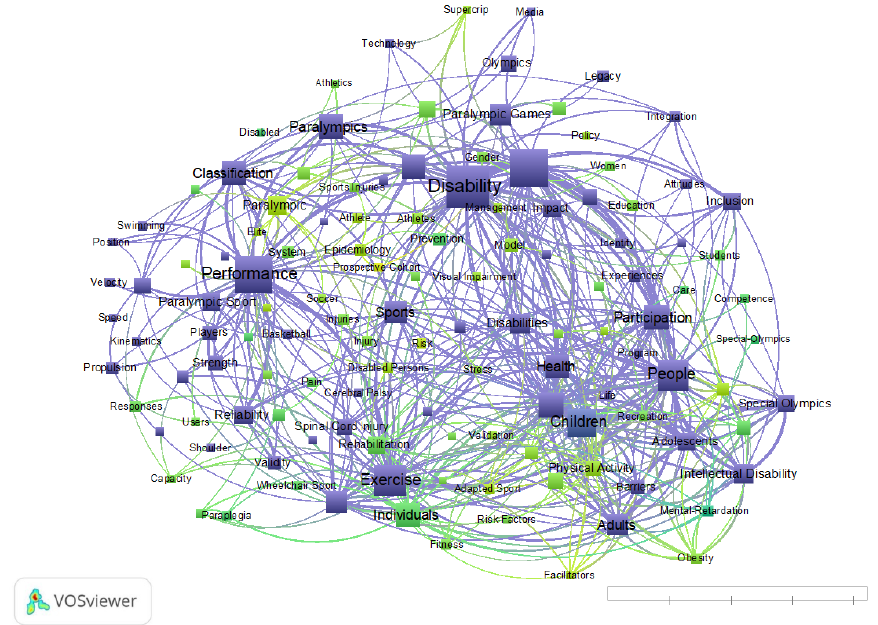
Figure 7. Keywords co-occurrence analysis of adapted sport publications between 2001 and 2020 with timeline.